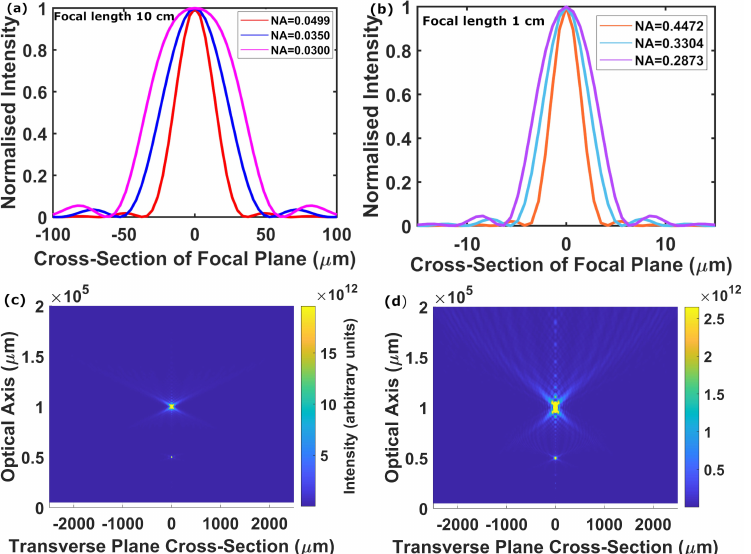
Figure 3. ( a , b ) Intensity profiles of focal spots generated by the 3000 nm wavelength design. The pro- files shown are for the entire device in the crystalline phase (full semi-aperture), and for two gradually decreasing semi-apertures achieved via switching the outer ring-like region to the amorphous state. The profiles are all normalised to the same scale to allow easier comparison of the shapes. ( a ) Red is NA = 0.0499 (R = 0.5 cm), blue is NA = 0.0350 (R = 0.35 cm), magenta is NA = 0.0300 (R = 0.30 cm). ( b ) Orange is NA = 0.4472 (R = 0.5 cm), light blue is NA = 0.3304 (R = 0.35 cm), purple is NA = 0.2873 (R = 0.30 cm). ( c , d ) Simulated intensity profiles along the optical axis and in a cross-section of the transverse plane for a focal length of 10 cm, revealing clear differences in both the spot size and the depth of focus. ( c ) Full device crystalline, NA = 0.0499. ( d ) Outer region amorphous, NA =